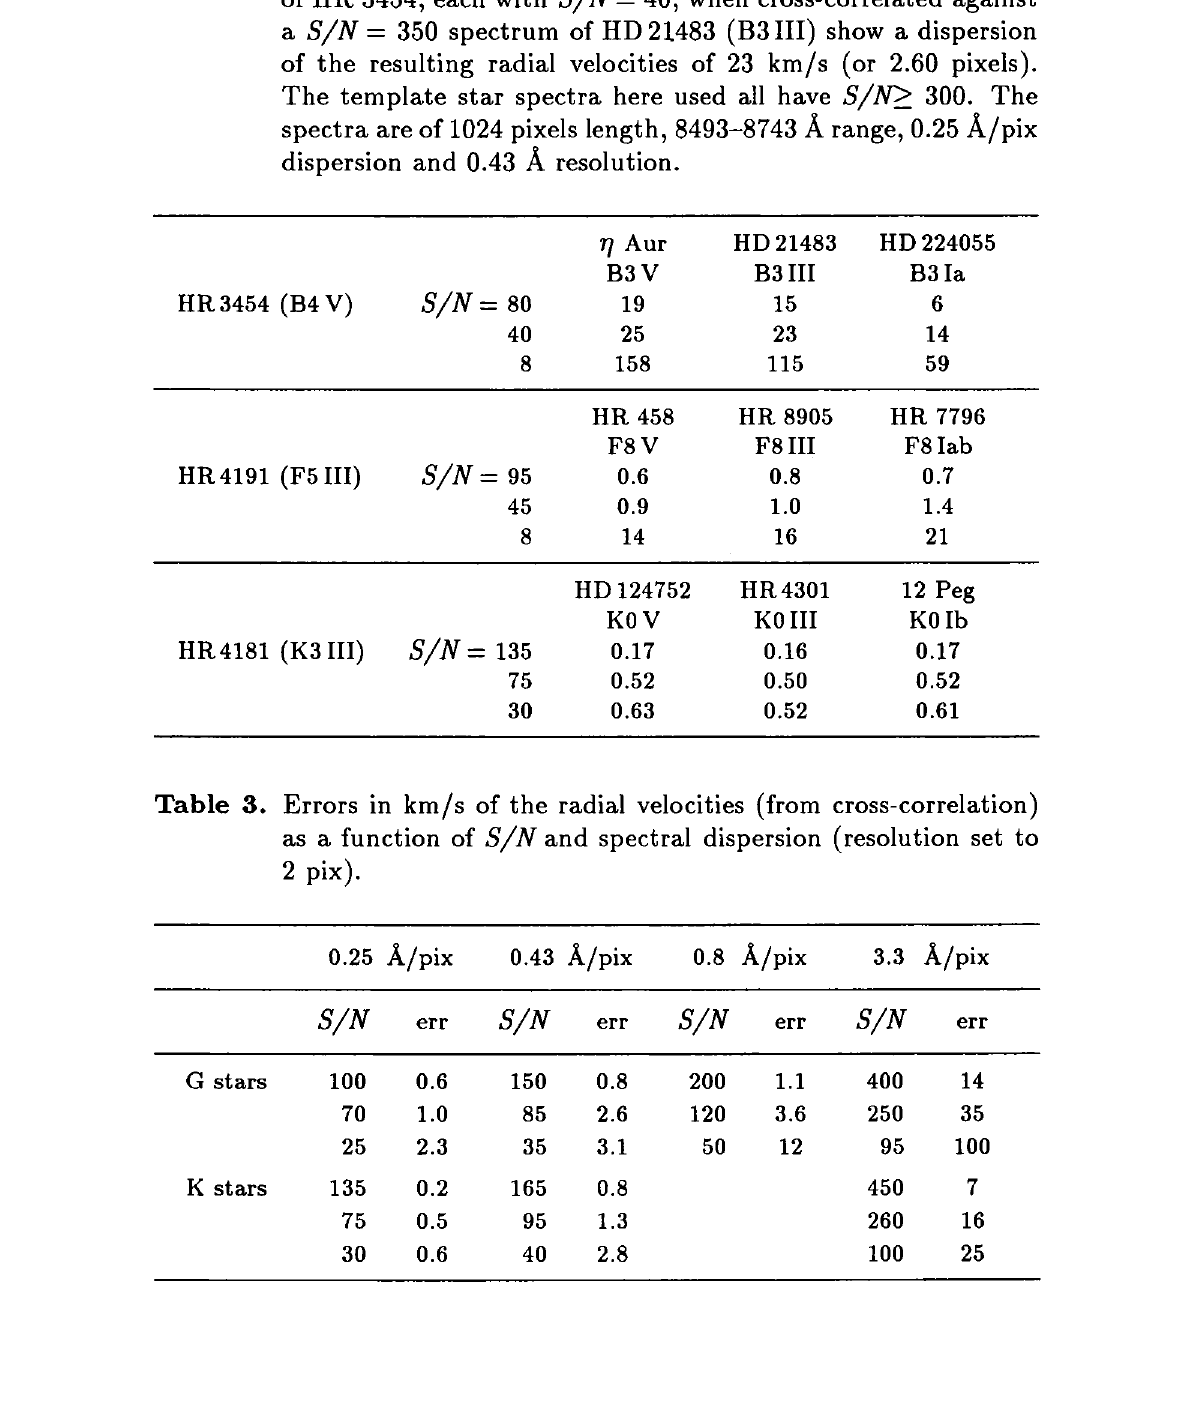
Table 2. Errors in km/s of the radial velocities as a function of the S/N ratio of the program star spectrum. For example, ten spectra of HR 3454, each with S/N = 40, when cross-correlated against a S/N = 350 spectrum of HD 21483 (B3III) show a dispersion of the resulting radial velocities of 23 km/s (or 2.60 pixels). The template star spectra here used all have S/N> 300. The spectra are of 1024 pixels length, 8493-8743 Á range, 0.25 Á/pix dispersion and 0.43 Â resolution.